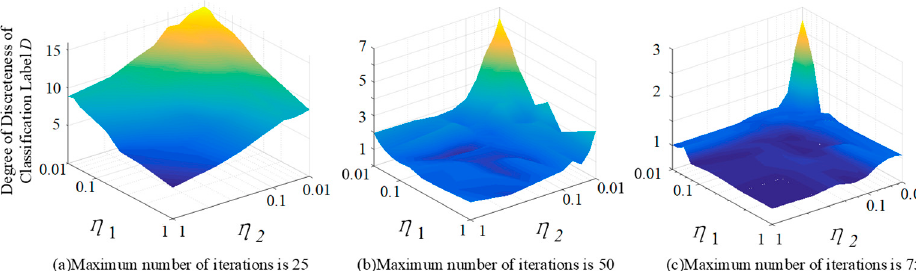
Figure 7. Degree of Discreteness of Classification Label under different iteration numbers and learning rates.